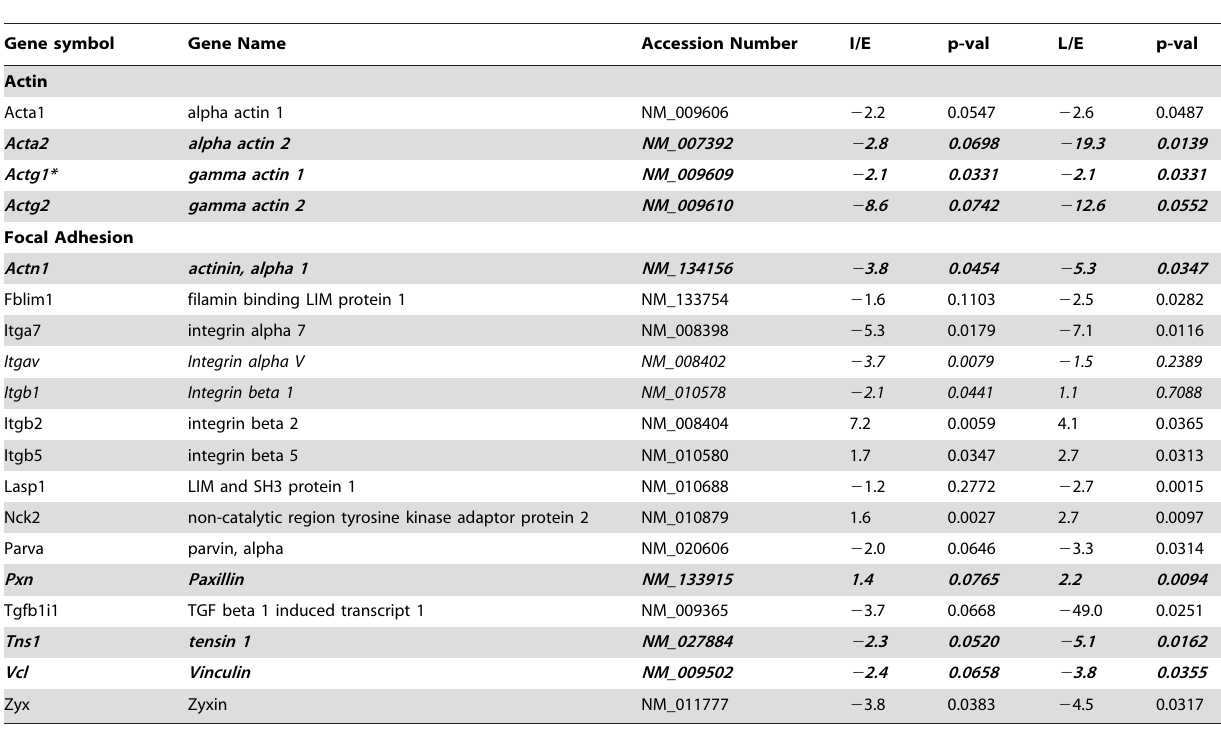
Table 2. Differentially expressed actin and focal adhesion associated genes in MOSE cell stages.